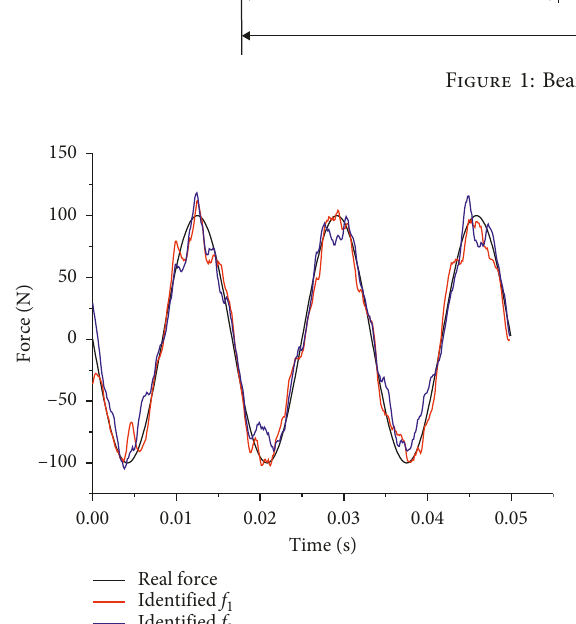
Figure 2: Real load history and identified loads of F